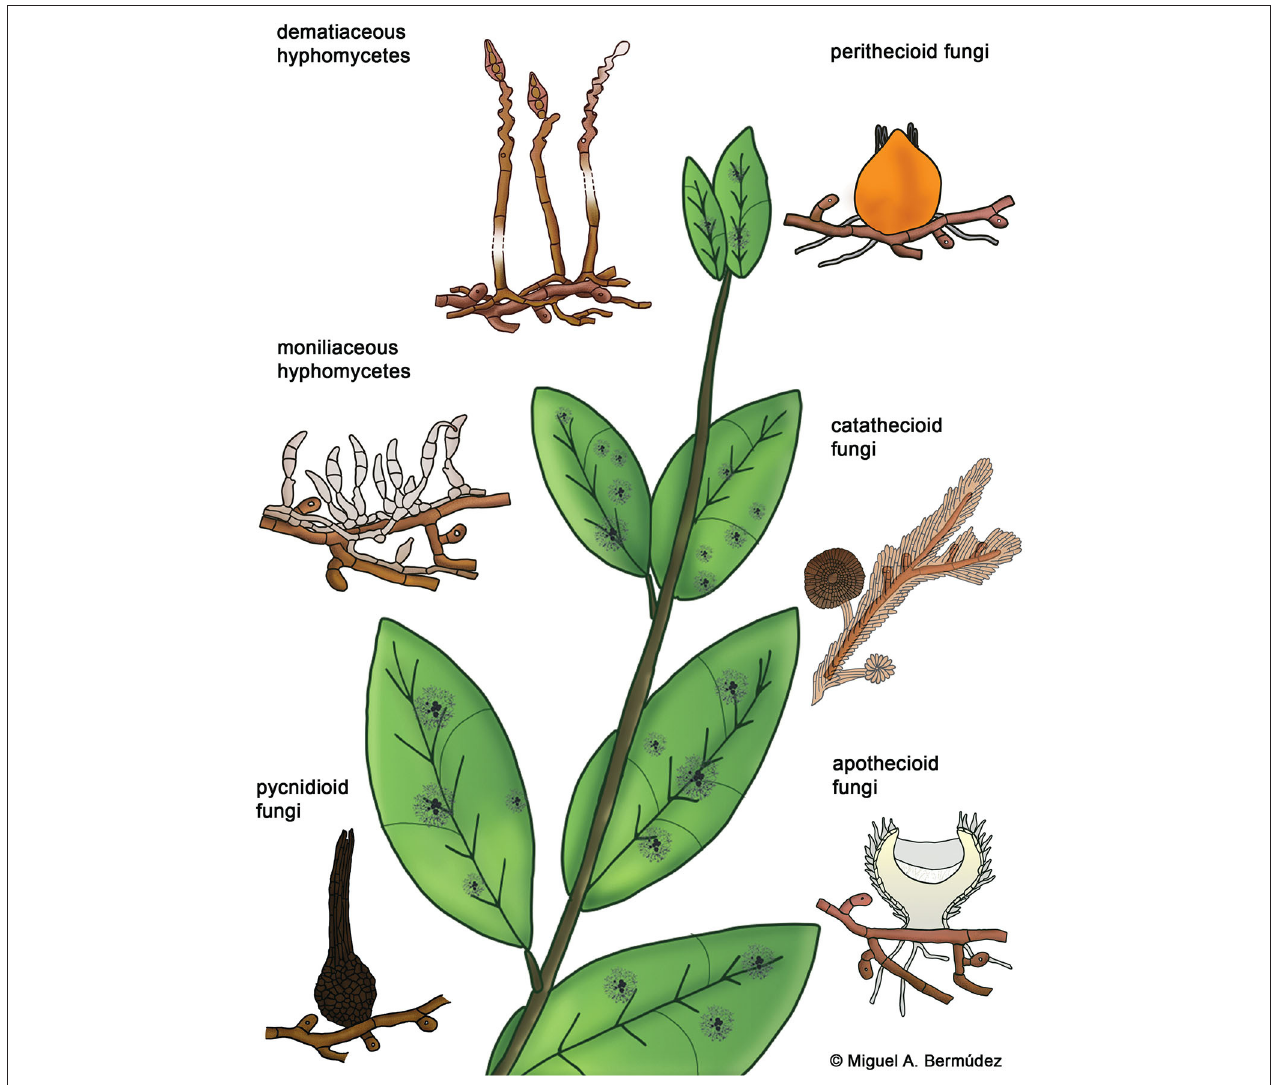
FIGURE 3 | Morphological groups of contact-biotrophic hyperparasitic fungi growing on colonies of Meliolales.